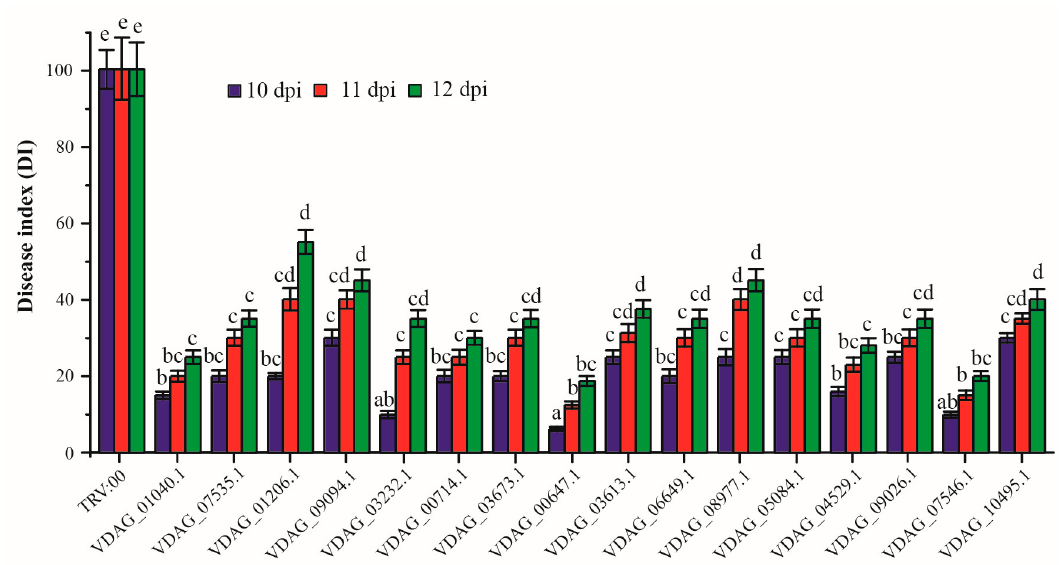
Figure 1. Disease index over time for N. benthamiana seedlings infiltrated with 16 Vd strains that had been silenced for a candidate virulence-related gene.